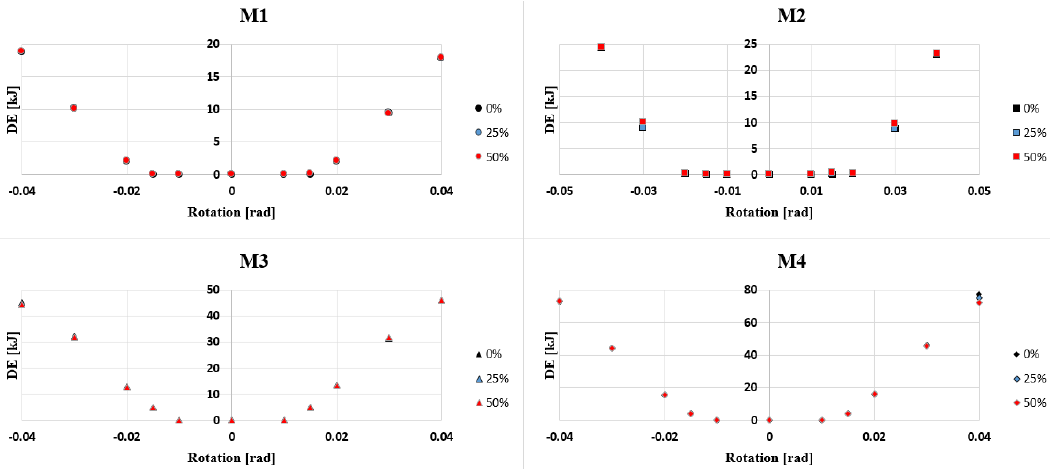
Figure 9. Dissipated energy vs. rotation for the configurations studied.